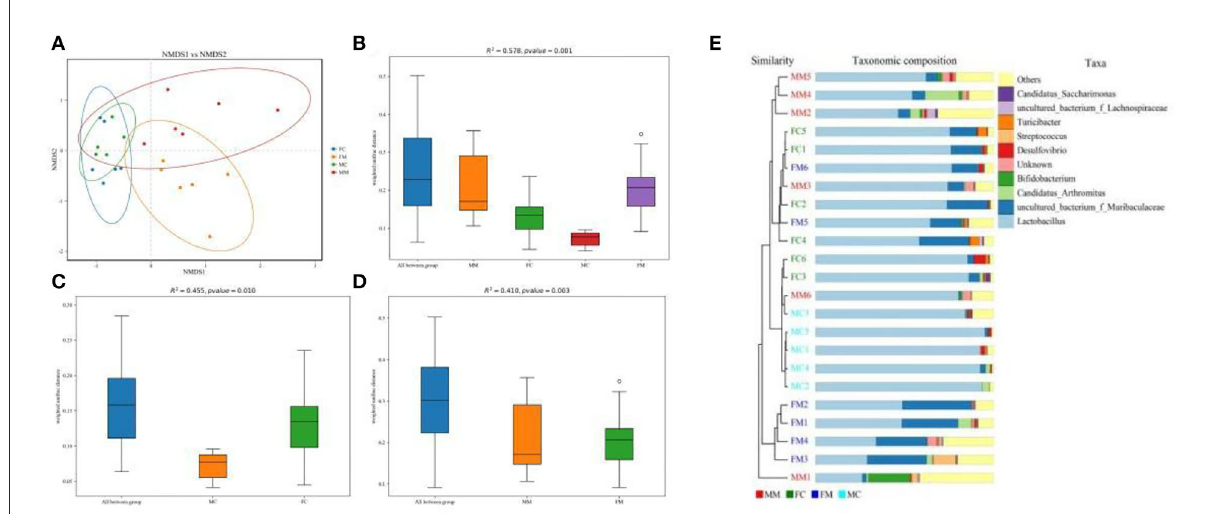
FIGURE3 (A) Non-metric multidimensional scaling (NMDS) analysis (based on weighted UniFrac distance). Different groups of samples were colored differently. Distance between the dots presented a difference. NMDS with stress levels of less than 0.2 is acceptable. The closer the sample is to the coordinates, the higher the similarity. (B–D) Analysis of similarities (ANOSIM) (based on weighted UniFrac distance) can test for a significant difference in β -diversity among samples of different groups. The y-axis represents β -distance; the box above “All between *” represents the β -distance data of samples of all groups, while the box above “All within *” represents the β -distance data of samples within all groups. The closer the R -value is to 1, the difference between groups is higher than the difference within groups; the smaller the R -value is, the smaller difference between groups; and the value of p < 0.05 indicates high reliability of the test. (E) Combination of the phylogenetic tree and histogram based on the unweighted group average clustering